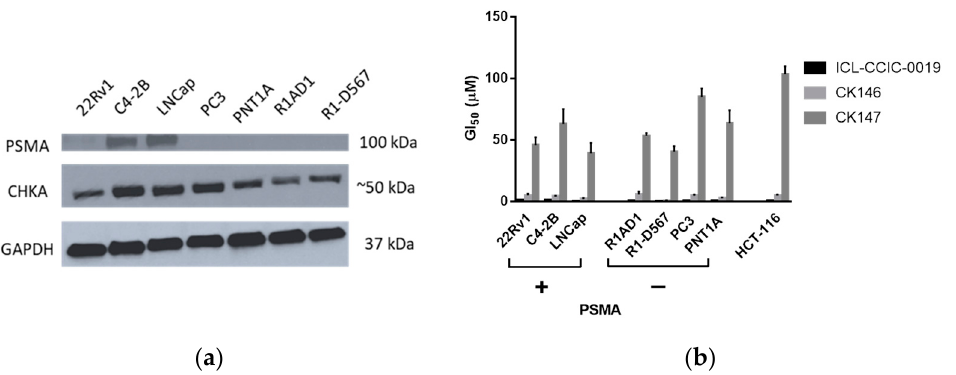
Figure 4. Antiproliferative activity characterization of ICL-CCIC-0019, CK146 and CK147. ( a ) Im- munoblotting analysis of PSMA and CHKA in 22Rv1, C4-2B, LNCap, PC3, PNT1A, R1-AD1 and R1- D567 cell lines ( n = 2); ( b ) Growth inhibitory activity comparison among ICL-CCIC-0019, CK146 and CK147 in 22Rv1, C4-2B, LNCap, PC3, PNT1A, R1-AD1, R1-D567 and HCT-116 cell lines ( n = 6, mean ± SD).